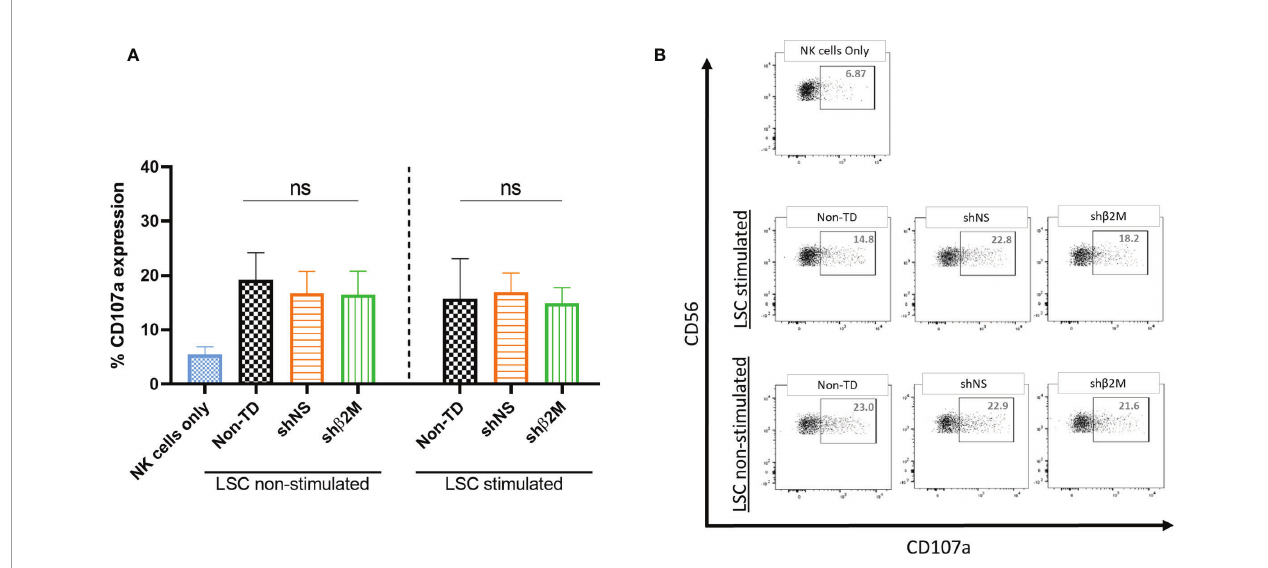
FIGURE 7 | Silencing HLA class I expression on LSCs does not affect NK cell responses. (A) Expression levels of the degranulation marker (CD107a) on NK cells co-cultured at target: effector ratio of 1:2 with non-transduced (Non-TD), non- silenced (shNS) and sh b 2M-silenced (sh b 2M) unstimulated or 48 hours IFN ɣ - stimulated limbal stem cells (n=3). (B) Representative dot plots of NK cell degranulation measured by the expression of CD107a. Statistical analysis was performed by one-way ANOVA. Data are presented as mean ± SD and comparisons were performed using Non-TD LSCs as reference, ns: no signi fi